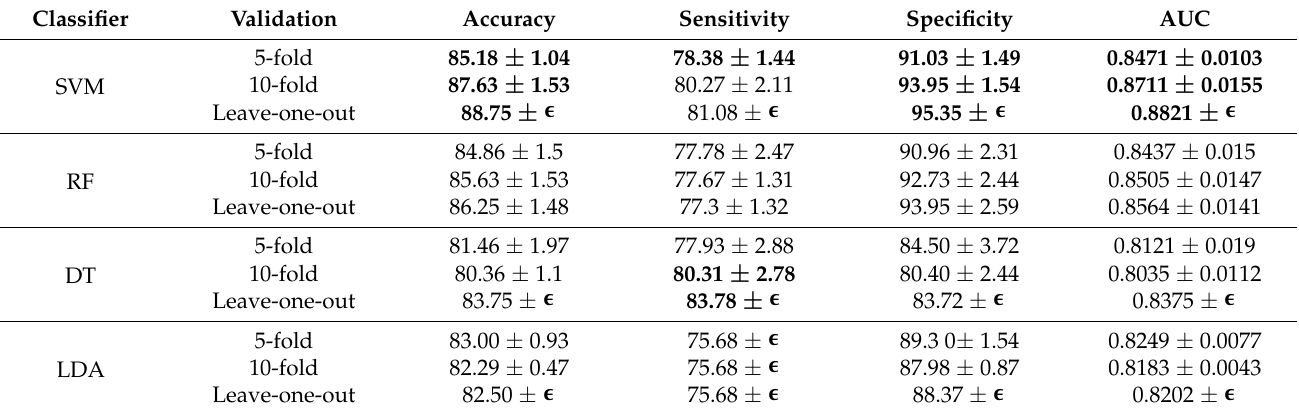
Table 8. Comparison of experimental results of classification accuracy (%), sensitivity (%), specificity (%), and AUC (in terms of mean ± standard deviation) using the different classifiers for only our proposed feature set (FS7), where